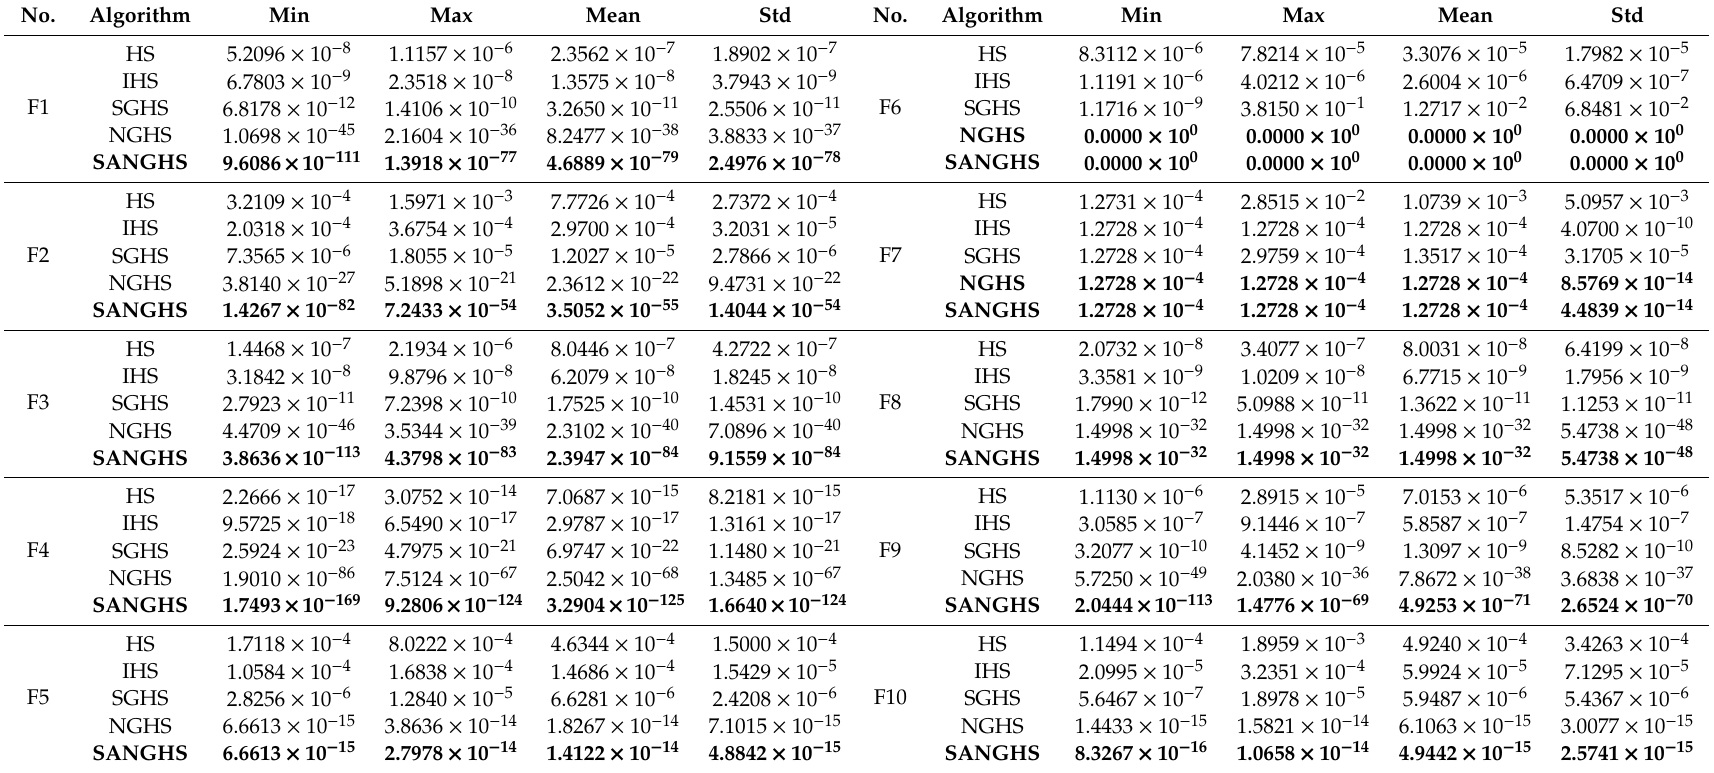
Table 2. Experimental results of five algorithms for 10 problems with D =